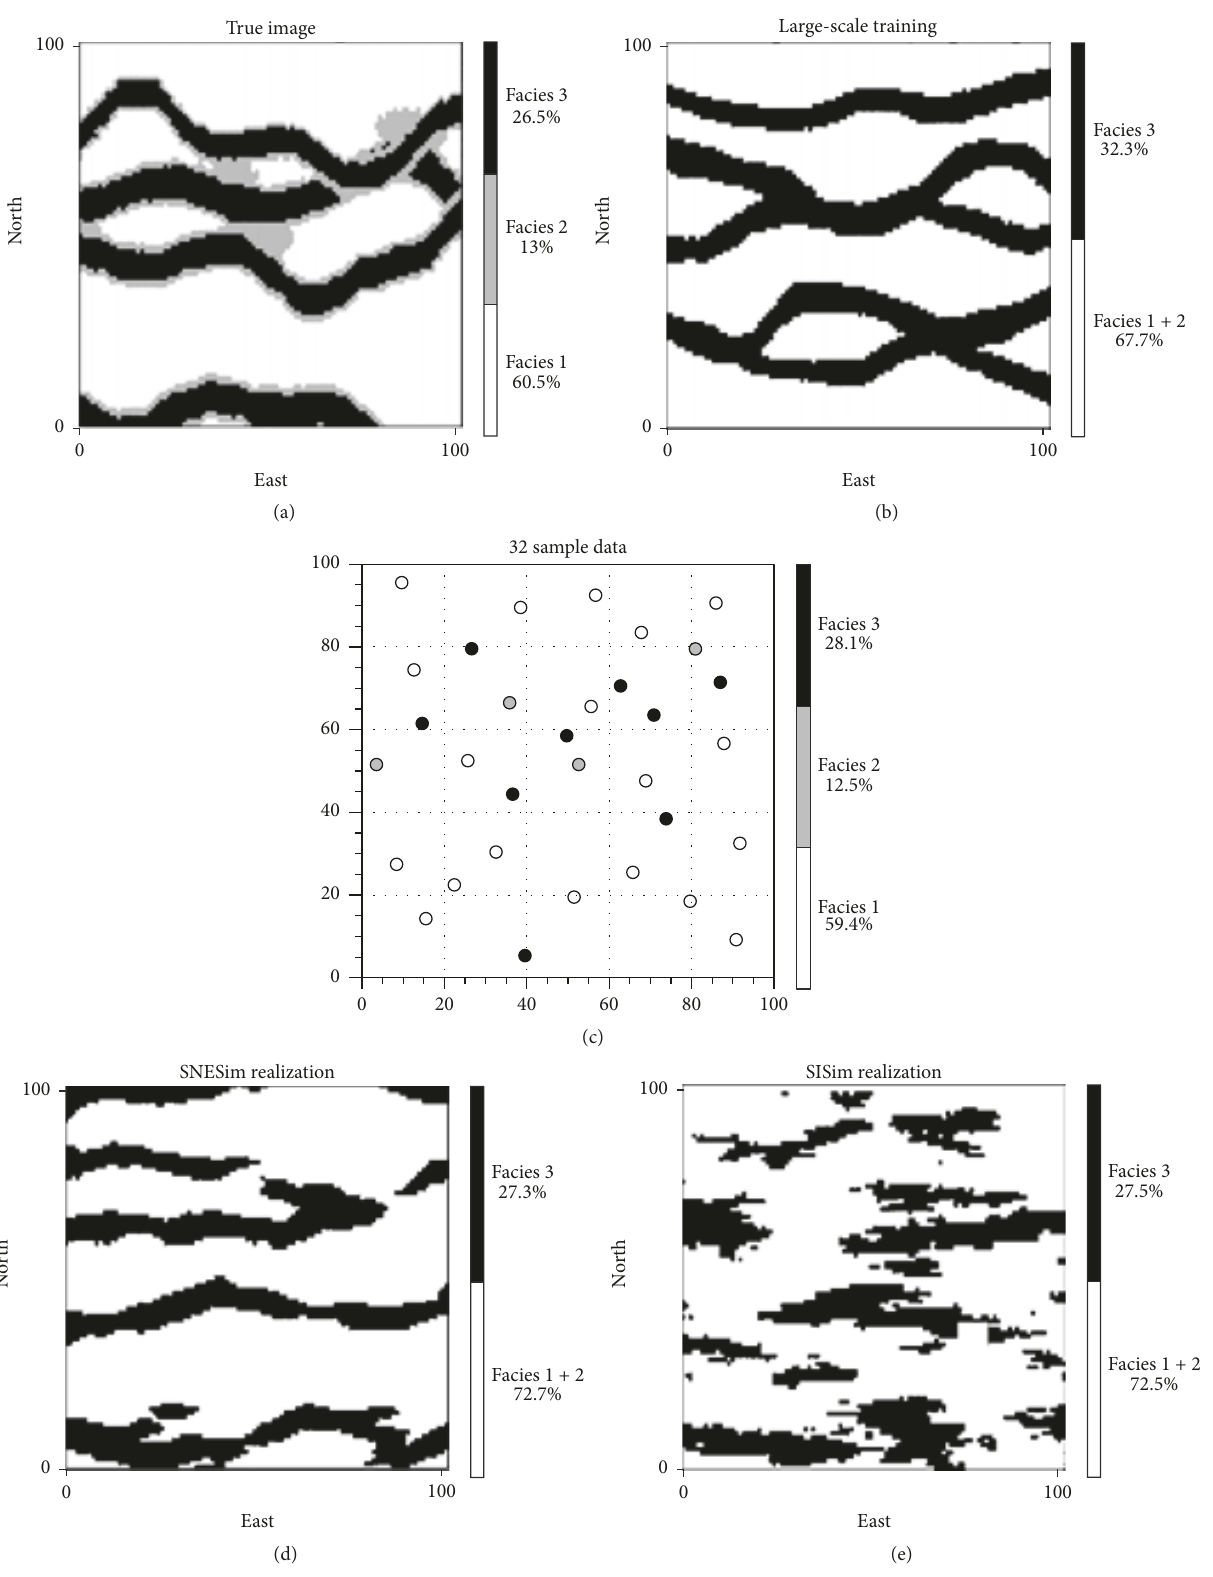
Figure 2: Example of MPS simulation of a meandering river system (after Strebelle